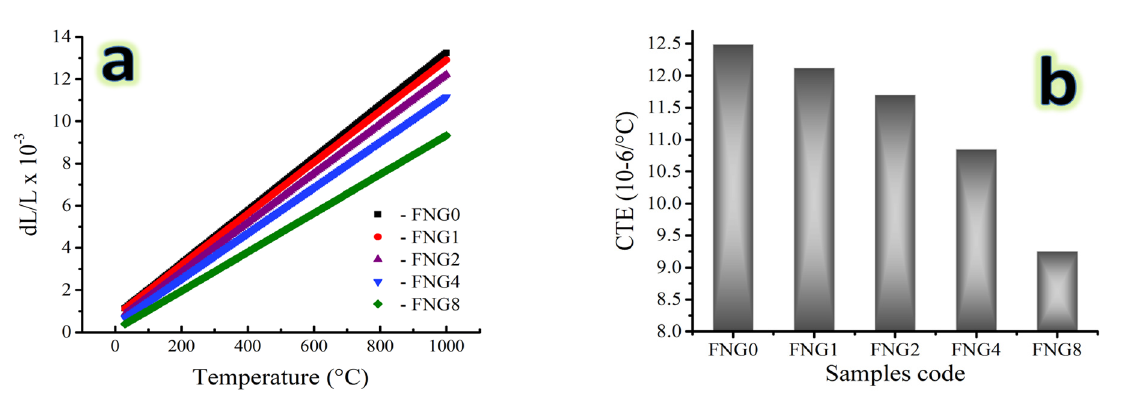
Figure 9. ( a ) Thermal expansion behavior and ( b ) CTE value of the sintered